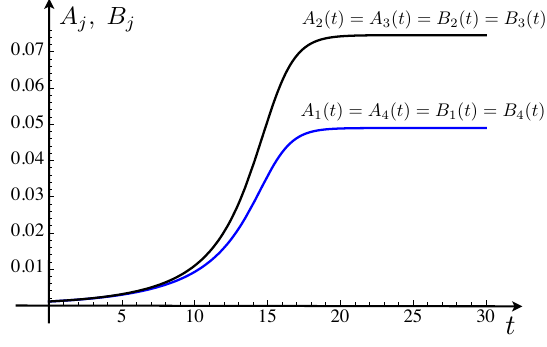
Fig. 9: Numerical solution of the amplitude equa- tions (15) for the parameter values P = 1 . 1 , H = 2 . 2 , L = 4 . 7 , α 1 = α 2 = 0 , β 1 = − 3 , β 2 = 3 , β 3 = β 4 = 1 , and β 5 = β 6 = − 5